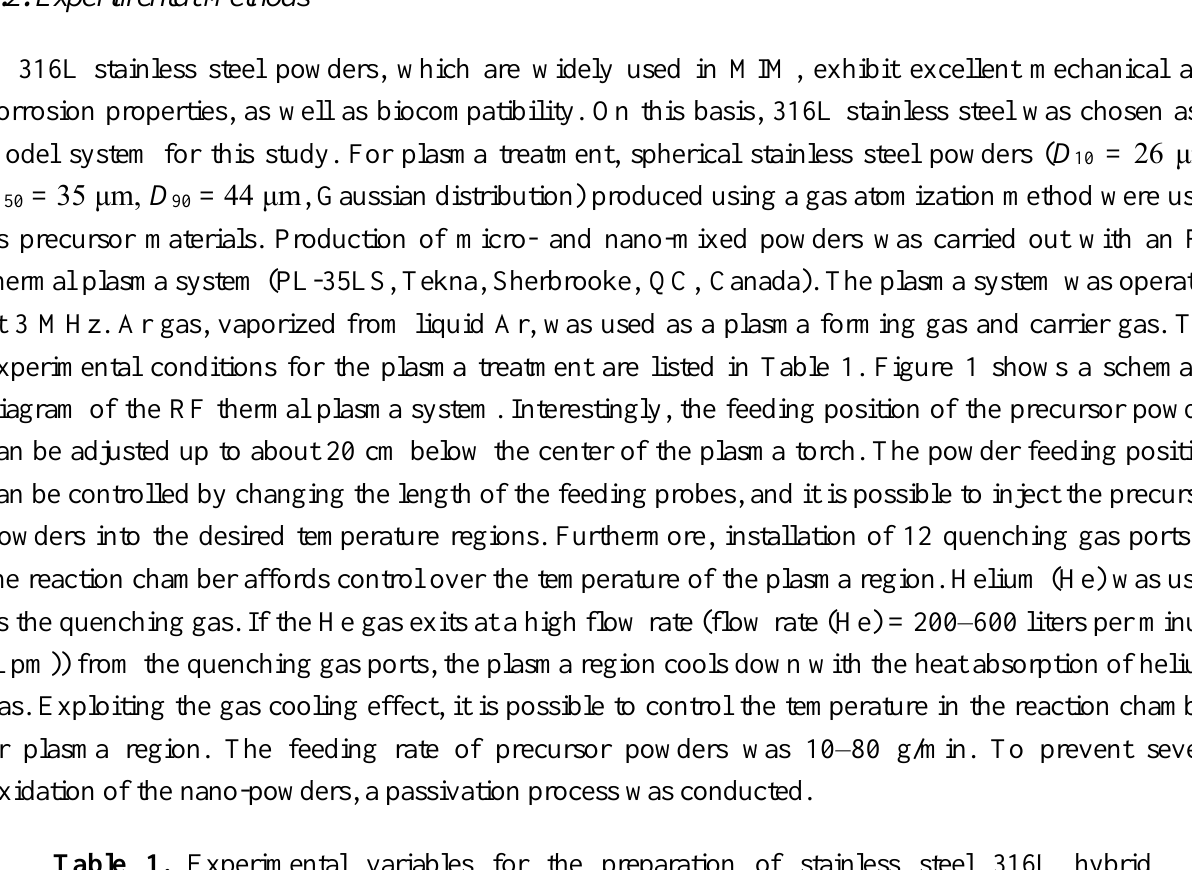
Table 1. Experimental variables for the preparation of stainless steel 316L hybrid micro-nano-powders using RF plasma